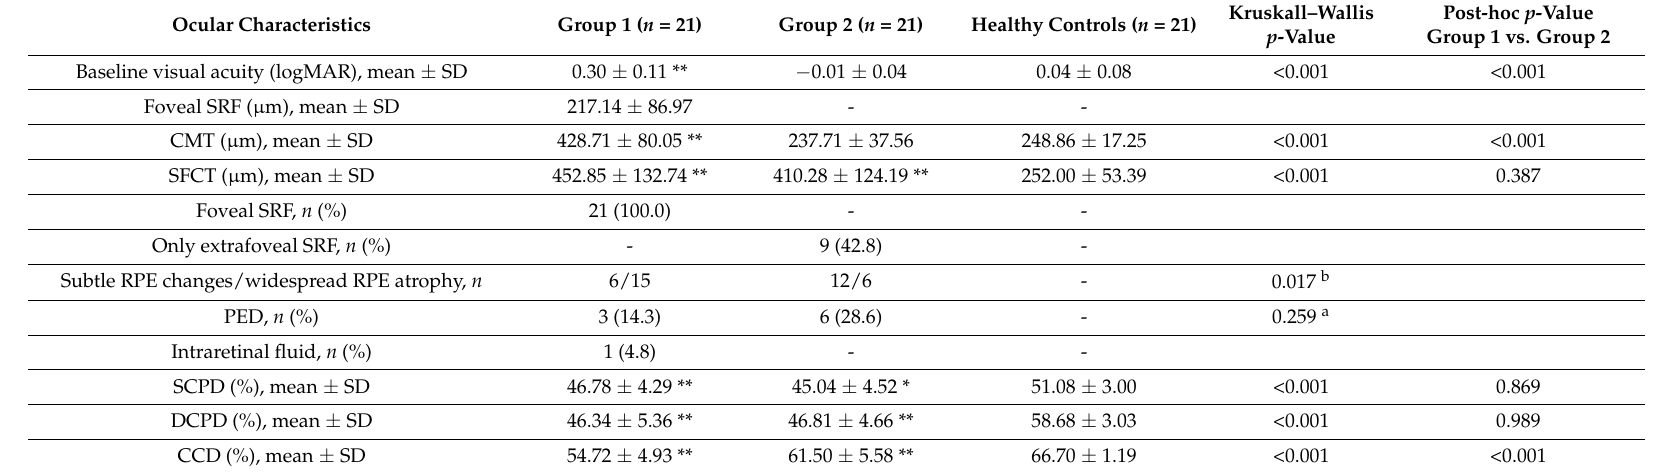
Table 1. Ocular characteristics of diseased eyes (group 1), fellow eyes (group 2) and healthy controls. Ocular Characteristics